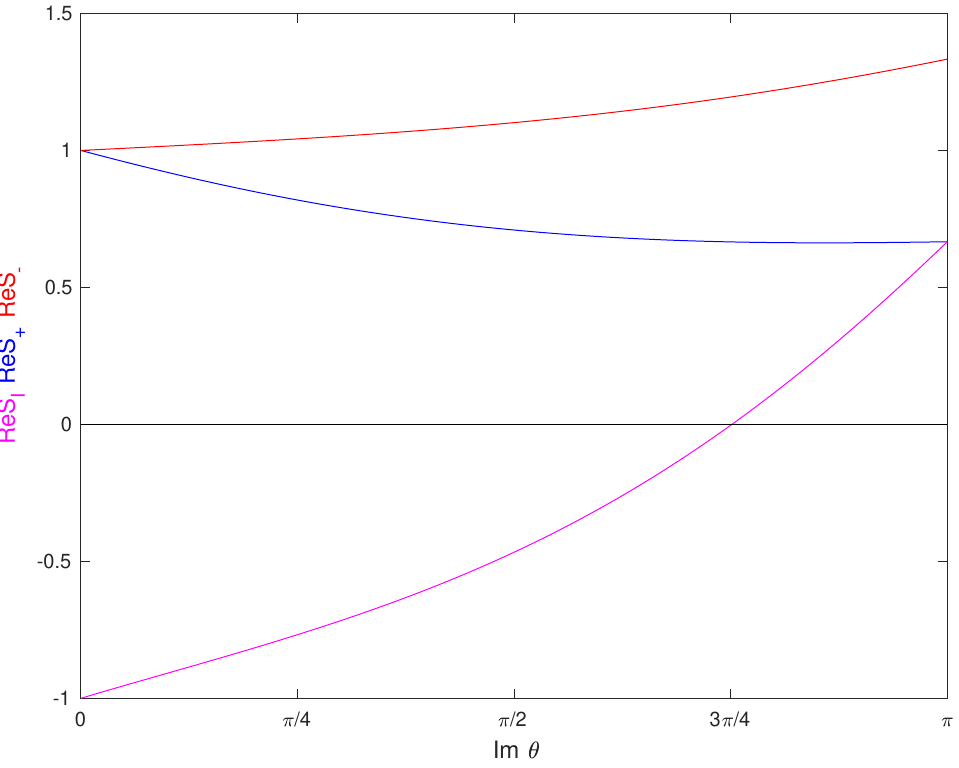
Figure 9. Other vertex for N = 6 obtained by maximizing the functional F = Re[ S 1 ( z 0 ) (cid:0) (cid:11)S 2 ( z 0 )] with (cid:11) = 2 : 5 ; z 0 = 0 : 3 i . We plot S I (purple), S + (blue) and S (cid:0) (red) on the imaginary axis of (cid:18) , i.e. (cid:18) = i(cid:17) , 0 (cid:20) (cid:17) (cid:20) (cid:25) . This should be compared with the integrable model, see (cid:12)gure 7. The same vertex can be found for other values of N